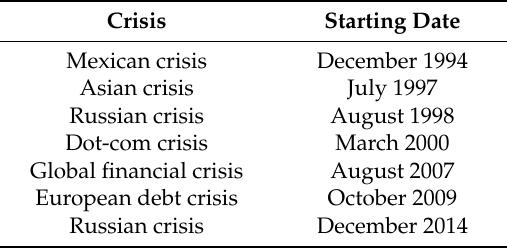
Table 6. Crisis start dates. Source: created by